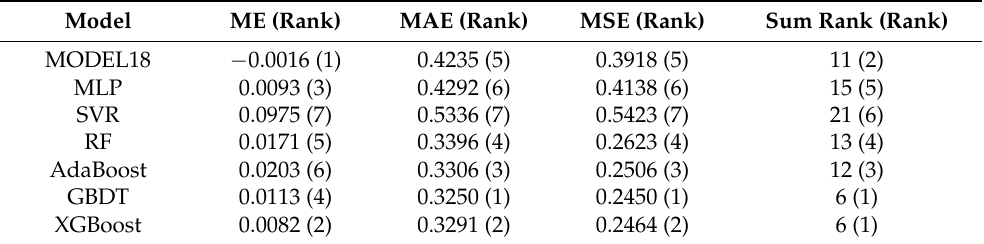
Table 9. Comparison of test results of crown profile models for China fir trees with different mod- eling methods.